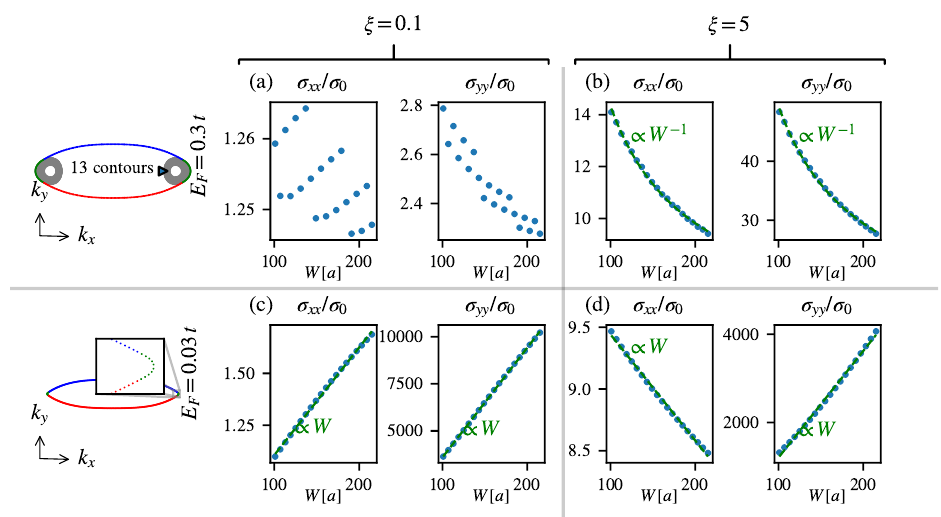
= 0.3 t , ξ = 0.1, (b) F = 0.03 t , ξ = 5. Other parameters F